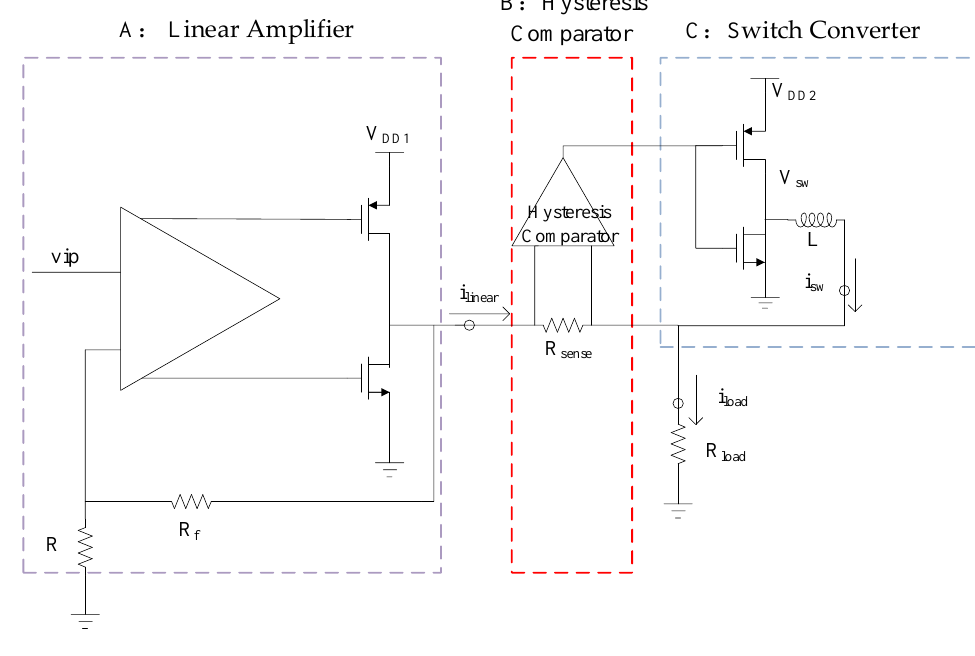
Figure 2. Typical architecture of a hybrid power supply modulator.